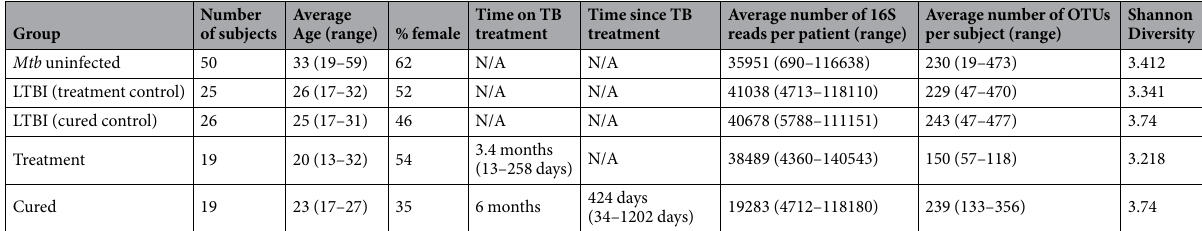
Table 1. Patient populations analyzed in this study by 16S rDNA sequencing. Data are divided into study groups described in the text. The number of subjects, average age, gender distribution, time on HRZE treatment or time since treatment, average number of 16S reads and subsequent OTUs, and Shannon diversity index are shown, if applicable. Mtb- uninfected controls are IGRA − , people with LTBI are IGRA + , and are the appropriate comparator group for individuals with active TB disease. The LTBI group was divided based on the comparisons being made to Treatment and Cured groups, matching for age (see methods).